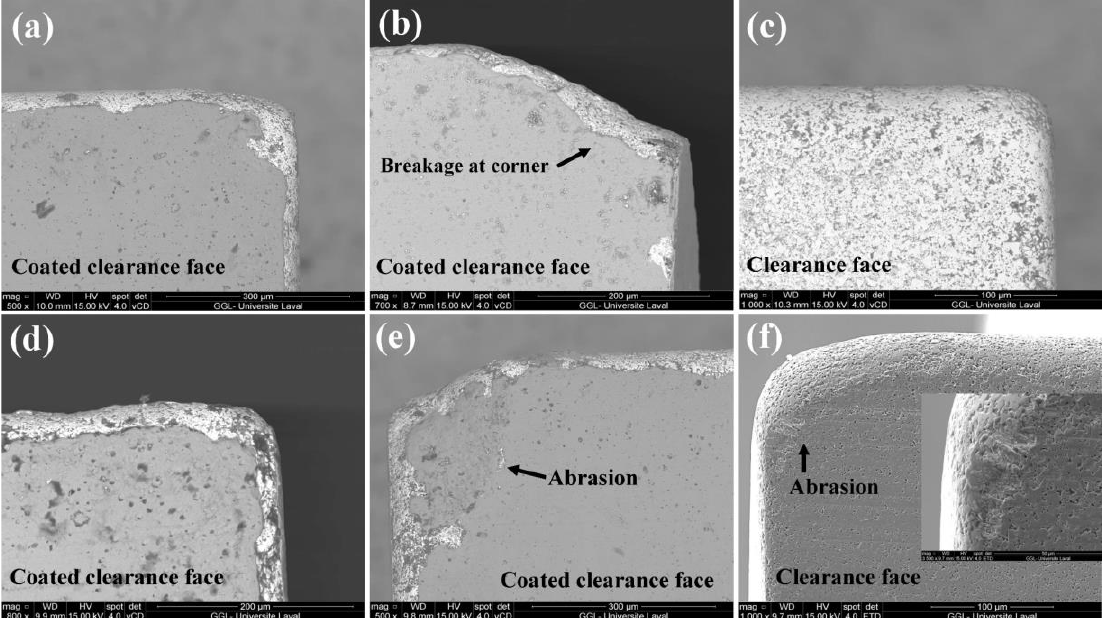
Figure 27. SEM micrographs of the corners of the tips (clearance face view): ( a – c ) saws #2, 4, and 6, respectively after 480 min of sawing and ( d – f ) saws #2, 4, and 6, respectively after 960 min of sawing.